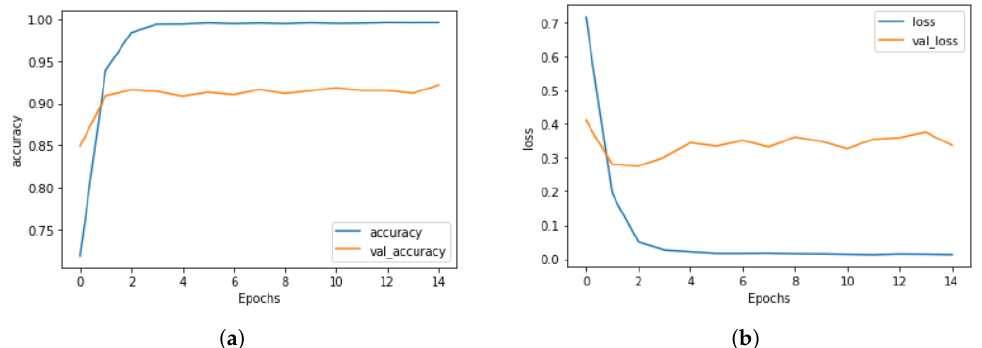
Figure 14. Accuracy and loss ROC curves of proposed convolutional neural network: ( a ) training and validation accuracy; ( b ) training and validation